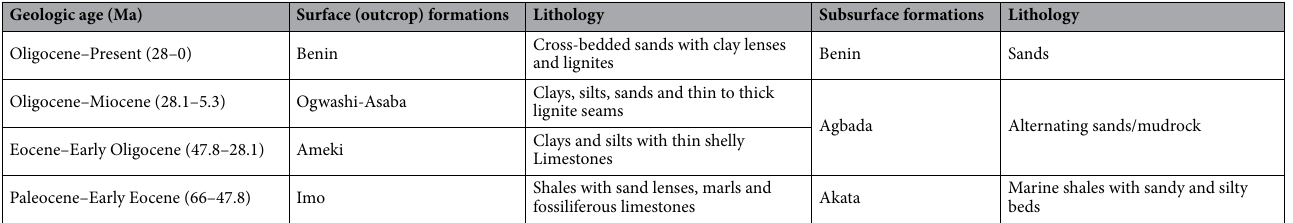
Table 2. Summary of surface and subsurface formations within the Niger Delta (After 16